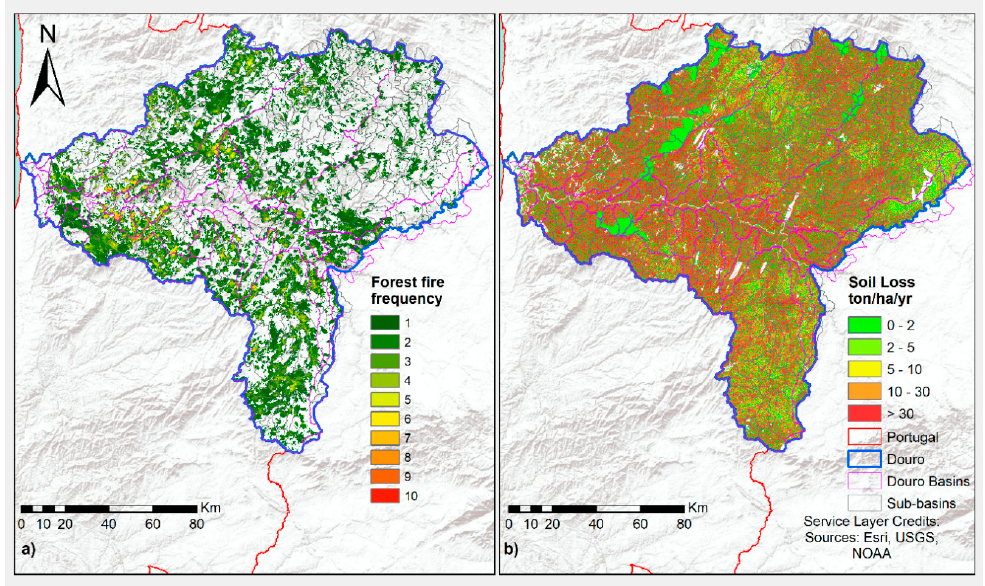
Figure 4. Spatial distribution of forest fire frequency ( a ) and soil loss ( b ) of the Douro river basin.